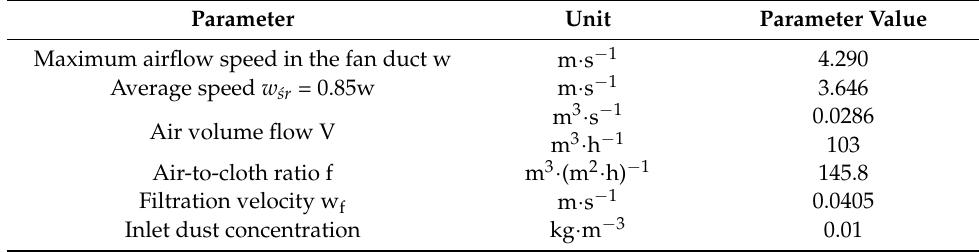
Table 4. Filtration parameters during testing of filtration